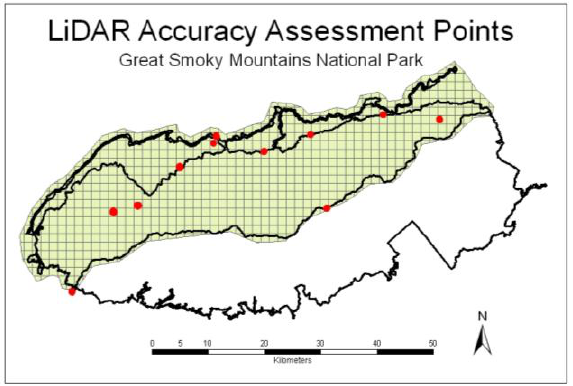
Figure 4 : Distribution of points used for accuracy assessment of the LiDAR data. Each location (shown in red) represents a cluster of points measured by DGPS and total station survey. Each cluster averages 27 points for a total of 299 Accuracy As- sessment (AA) points. The grid shows the data tiling scheme.